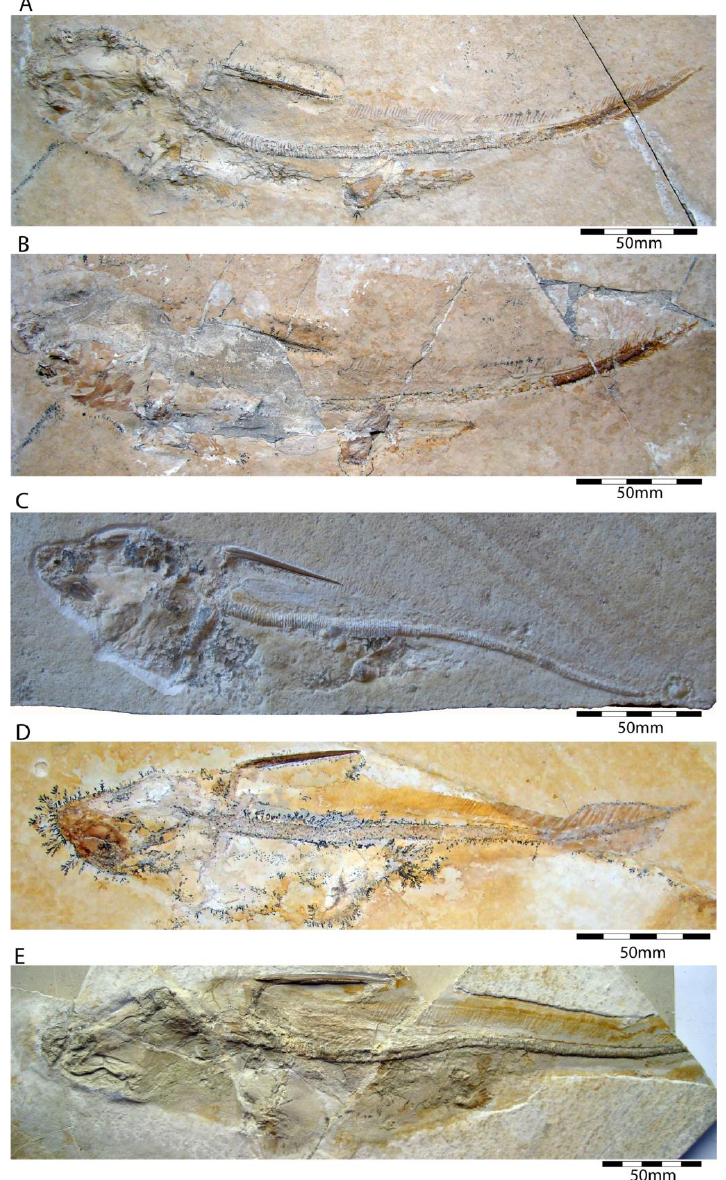
Figure 7. Specimens of † Elasmodectes avitus (von Meyer, 1862 [120]) from the Solnhofen Archipelago. ( A ) Holotype (SNSB-BSPG 1908 I 39a) from the early Tithonian Altmühltal Formation of Blumenberg near Eichstätt. ( B ) Counterpart of the holotype (SNSB-BSPG 1908 I 39b). ( C ) Male specimen (JME SOS 3149a) from the early Tithonian Altmühltal Formation of Blumenberg near Eichstätt displaying the pelvic claspers. ( D ) Holomorphic specimen (SMNK without number) displaying the well-preserved caudal fin from the early Tithonian Altmühltal Formation of Solnhofen. ( E ) Holomorphic specimen (JME SOS 4003) from the early Tithonian Altmühltal Formation of